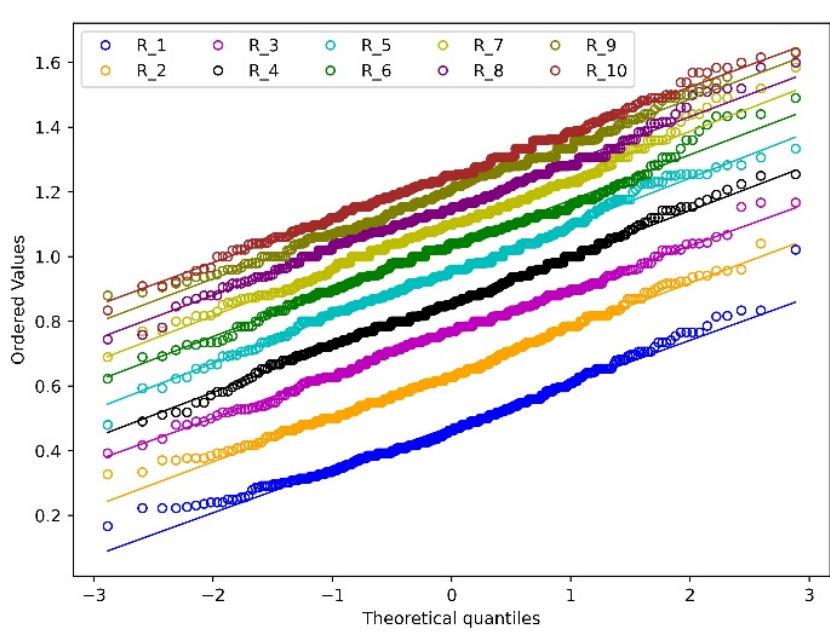
Figure 12. Normality analysis of wear depth.